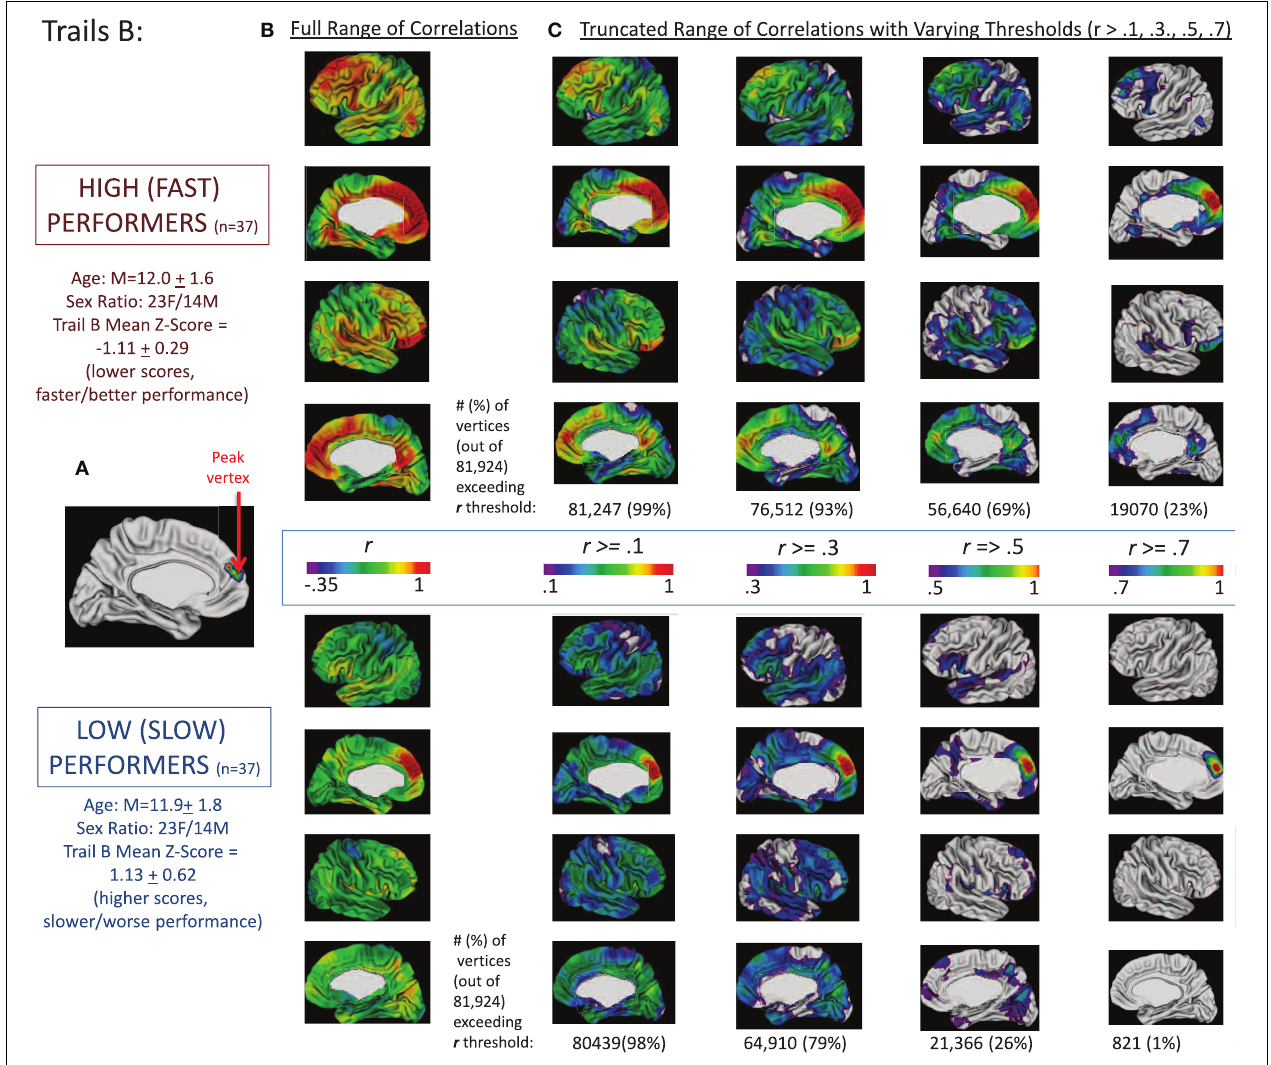
FIGURE 2 | Correlations between peak vertex thickness in the medial prefrontal cortex and the rest of the cortex in high ( n = 37) and low ( n = 37) performers on Trails B. The complete sample of 146 participants was divided into quartiles based on performance on Trails B (age-adjusted scores). We then ran two sets of correlations between the thickness of the peak vertex identified in prior analyses in medial prefrontal cortex [shown in (A) ; MNI coordinates: x = − 9, y = 51, z = 14] and all vertices in the left and right hemisphere for the group of high/fast performers (those with scores in the lower quartile—denoting faster performance; n = 37) and the low/slow performers (those with